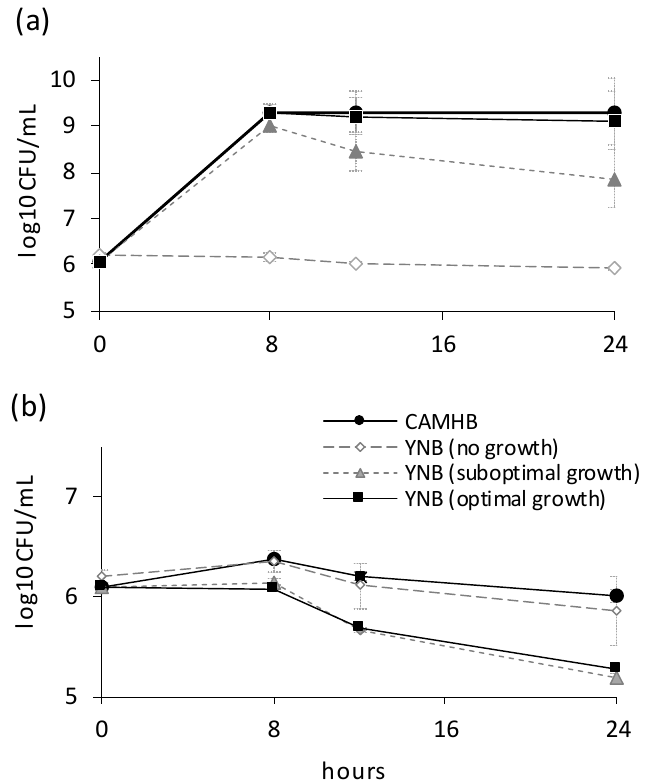
Figure 4. NPBD kills slow-growing cells of S. aureus at the same rate as rapidly growing cells. Rate of growth of S. aureus ATCC ATCC29213 in CAMHB and in media supporting no growth, suboptimal growth and optimal growth with ( a ) no NPBD and ( b ) 16 mg/L NPBD (2 × MICi). Yeast Nitrogen Broth formulations: YNB without additives (no growth); YNB with 0.01% w/v glucose and 0.0017% w/v Casamino acids (suboptimal growth); YNB with 0.5% w/v glucose and 1.7% w/v Casamino acids (optimal growth). Final formulation contained 1% DMSO.